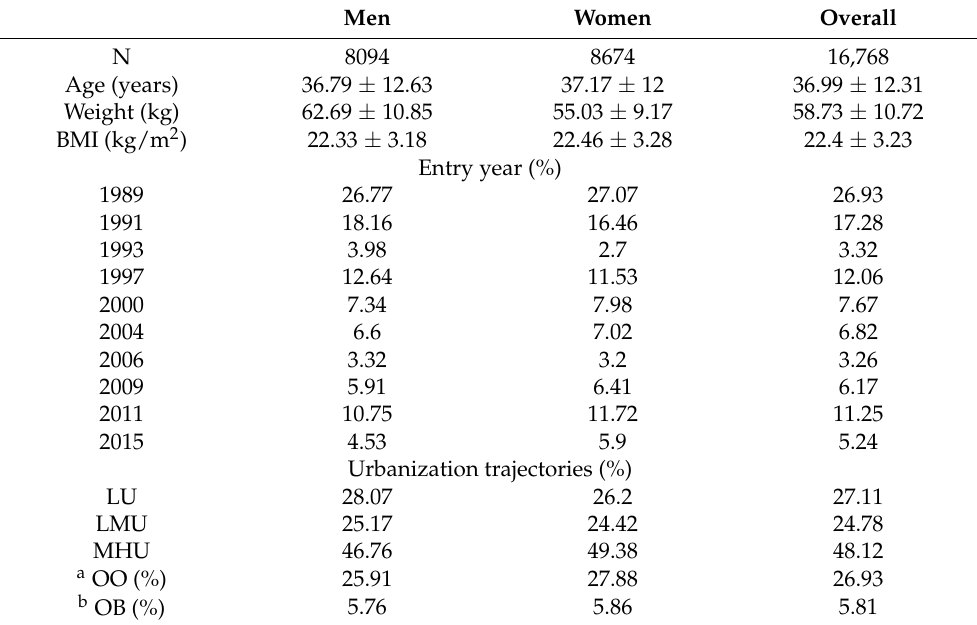
Table 1. Demographic characteristics of the baseline sample by gender.